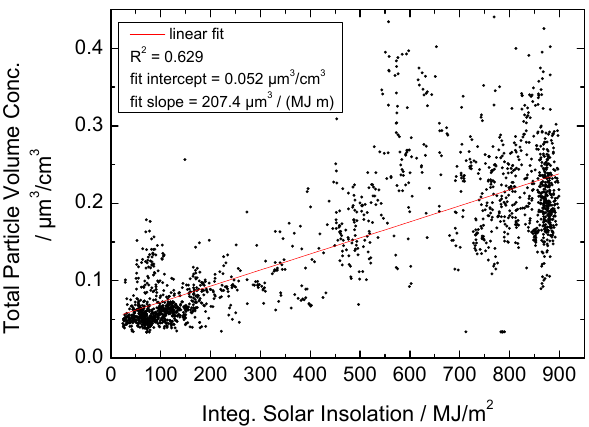
Fig. 10. Graph investigating the correlation between the particle volume concentration (y-axis, integrated over particle size) and the solar insolation integrated over the 20-day backward plume (x-axis) as calculated by FLEXPART. Also plotted is the linear regression line including slope, intercept, and coefficient of determina- tion.